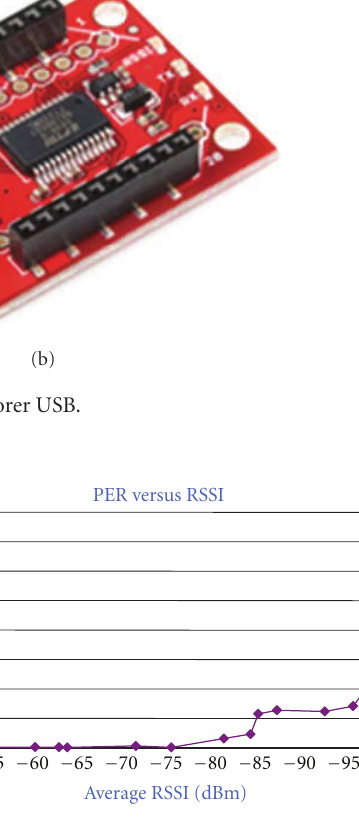
Figure 17: Representation of PER versus average RSSI in scenario 1.